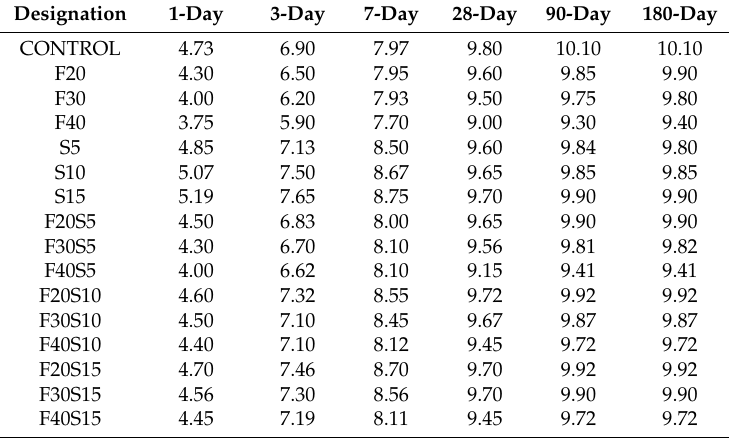
Table 3. Non-dehydrated water content (percentage) of binary and ternary cement pastes at various